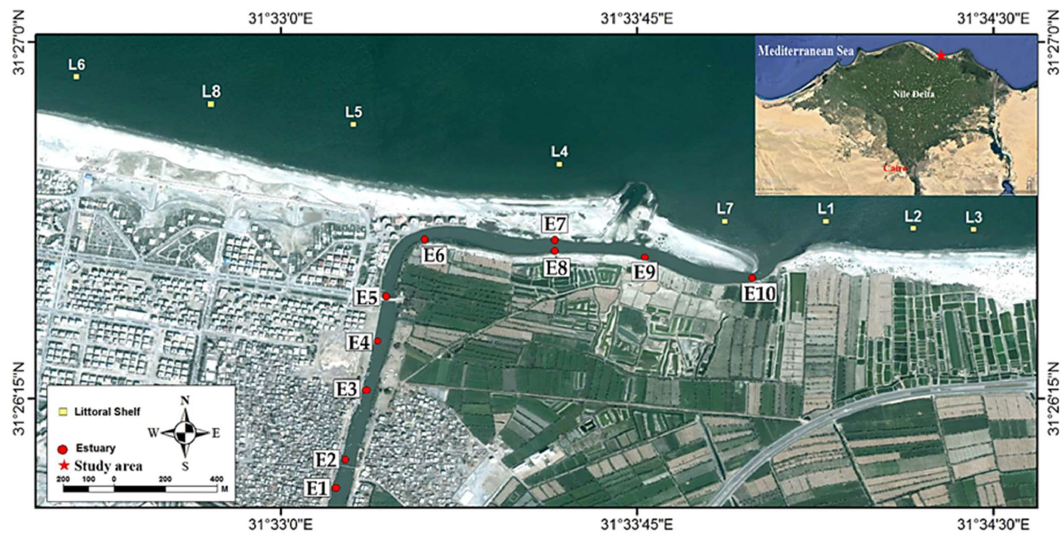
Figure 1. Location map of sampling points.